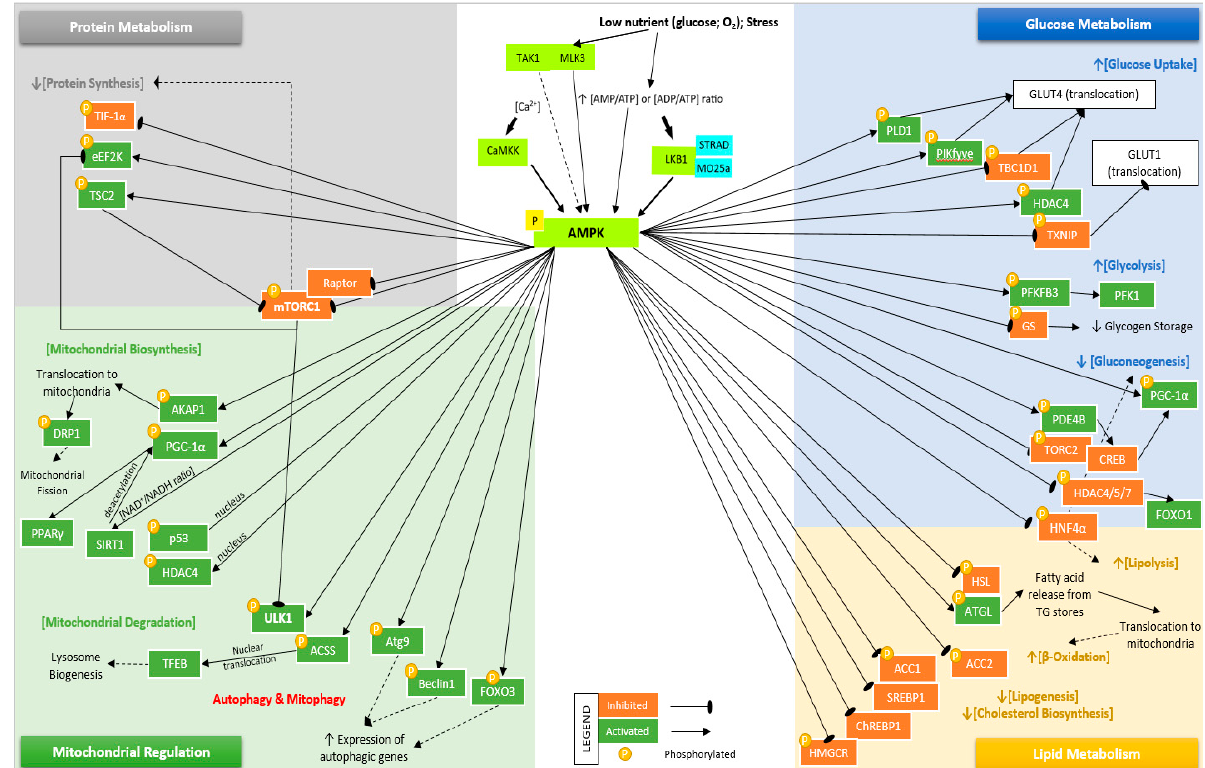
Figure 3. Summary of differentially expressed genes involved in the AMPK signaling pathway. Activation of AMPK occurs following phosphorylation of Thr172 (not shown) by LKB1, CaMKK, TAK1, and MLK3. Activated AMPK regulates glucose metabolism by increasing glucose uptake via translocation of GLUT4 by phosphorylating/inhibiting TBC1D1 and phosphorylating/activating PIKfyve, HDAC4, and PLD1. AMPK-mediated translocation of GLUT1 occurs follow- ing phosphorylation/inhibition of TXNIP. Glycolysis is stimulated via activation of PFKFB3, and glycogen storage is reduced by inhibition of GS. Inhibition of gluconeogenesis occurs following phosphorylation/inhibition of PDE4B, TORC2, HDAC4/5/6, and HNF4 α . AMPK regulates lipid metabolism by phosphorylating/inhibiting HSL, HNF4 α , and activating ATGL to increase lipolysis. An increase in β -oxidation occurs by phosphorylation of ACC2 and reducing fatty acid synthesis by phosphorylation of ACC1. AMPK decreases lipid and sterol synthesis by phosphorylating/inhibiting SREBP1, ChREBP, and HMGCR. AMPK inhibits protein synthesis by phosphorylating/inhibiting TIF-1 α , mTORC1, and RAPTOR, and phosphorylating/activating eEF2K and TSC2, which inhibit mTORC1. Lastly, mitochondrial functions are regulated by activated AMPK by activating mitochondrial biosynthesis. AMPK phosphorylates/activates AKAP1, DRP1, PGC-1 α , SIRT1, p53, and HDAC4. AMPK activates mitophagy and autophagy pathways by phosphorylating/activating ULK1, ACSS, Atg9, Beclin1, and